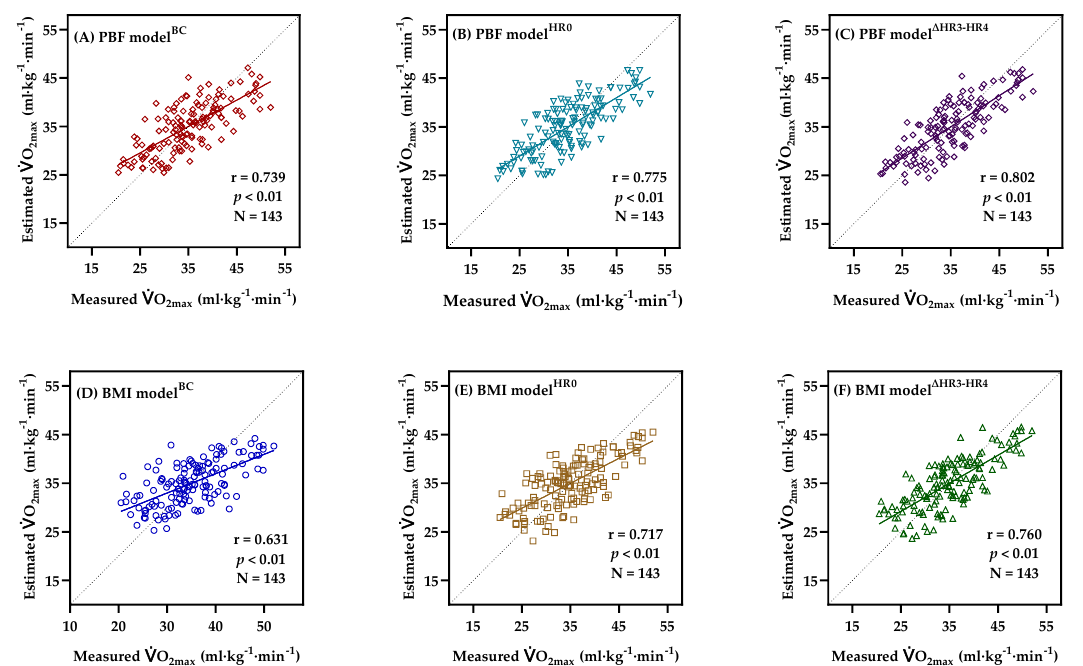
. VO 2max obtained from PBF model BC ( A ), PBF model HR0 • O 2max obtained from PBF model BC ( A ), PBF model HR0 ( B ), • O 2max obtained from PBF model BC ( A ), PBF model HR0 ( B ),